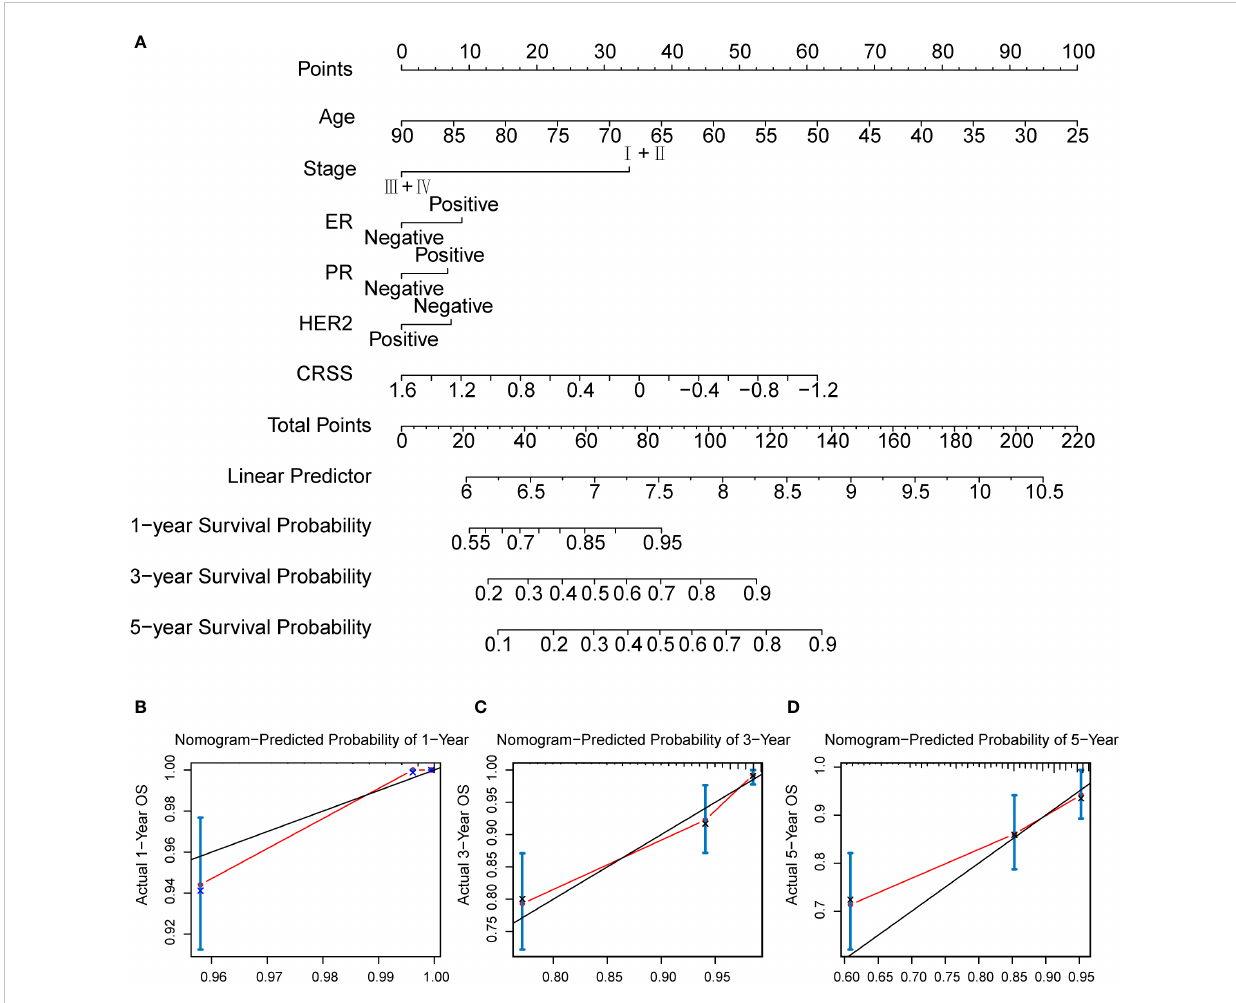
FIGURE 8 The calculation of centrosome-related prognostic nomogram. (A) The prognostic nomogram to predict the 1-, 3-, and 5-year OS of breast cancer patients. For each patient, we calculated the points of the clinical – pathological features and summed up the points to obtain the total points. The predicted 1-, 3-, and 5-year OS can be estimated based on the total points of each patient. (B) The calibration curves for predicting patient survival at 1- year OS. (C) The calibration curves for predicting patient survival at 3-year OS. (D) The calibration curves for predicting patient survival at 5-year